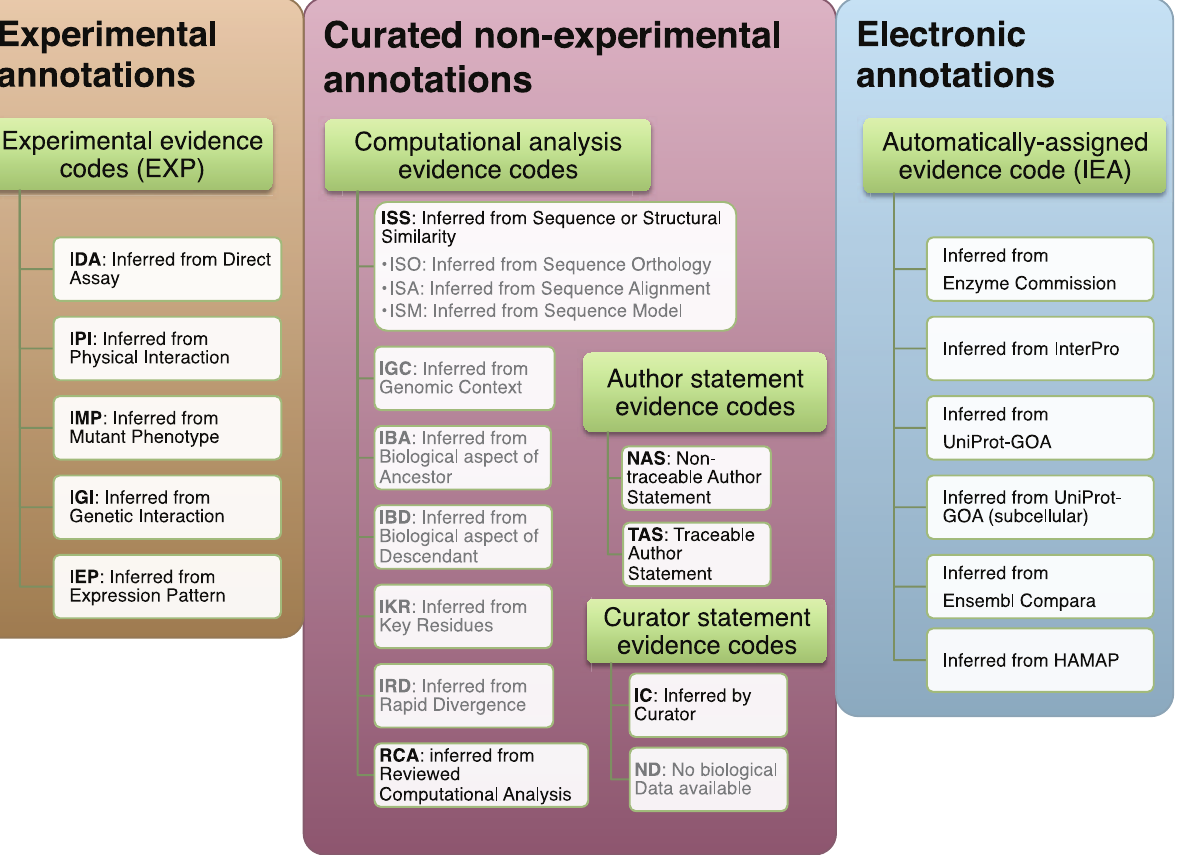
Figure 1. A list of the Gene Ontology (GO) evidence and reference codes we analyzed. We group the GO evidence codes in three groups: experimental, non-experimental curated, and electronic. Gray text denotes the evidence codes that were not included in the analysis: they are either used to indicate curation status/progress (ND), are obsolete (NR), or there is not enough data to make a reliable estimate of their quality (ISO, ISA, ISM, IGC, IBA, IBD, IKR, IRD). The subdivision of the evidence codes (green rectangles) reflects the subdivision available in the GO documentation: http:// www.geneontology.org/GO.evidence.shtml.